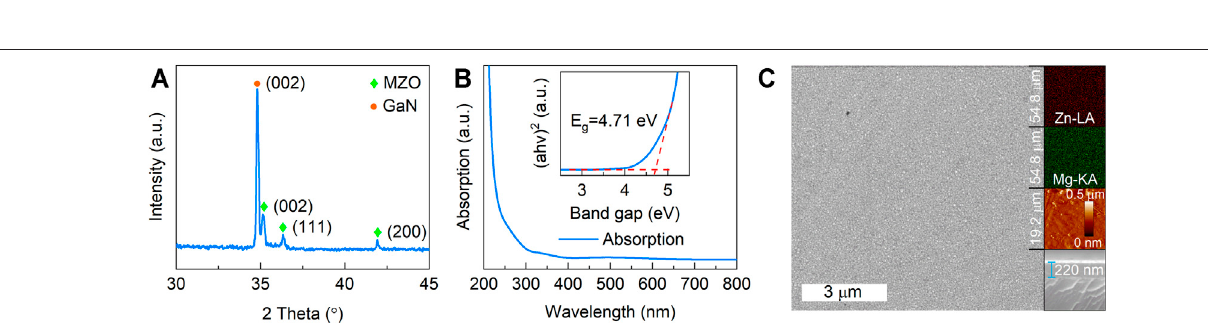
Frontiers in Materials |